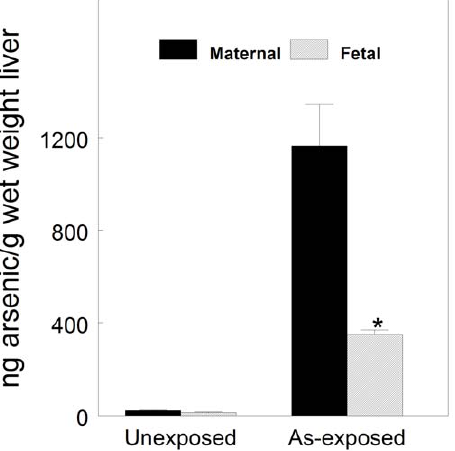
Figure 1. Determination of As levels in livers of pregnant dams and GD18 fetuses after 10 days exposure to 49 ppm As (as NaAsO2) in drinking water. Means 6 SD. P , 0.01.